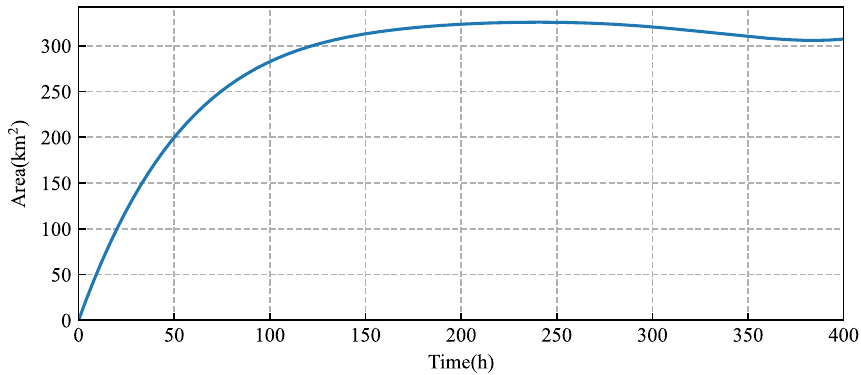
Fig. 8 “96.8” flood inundation area time